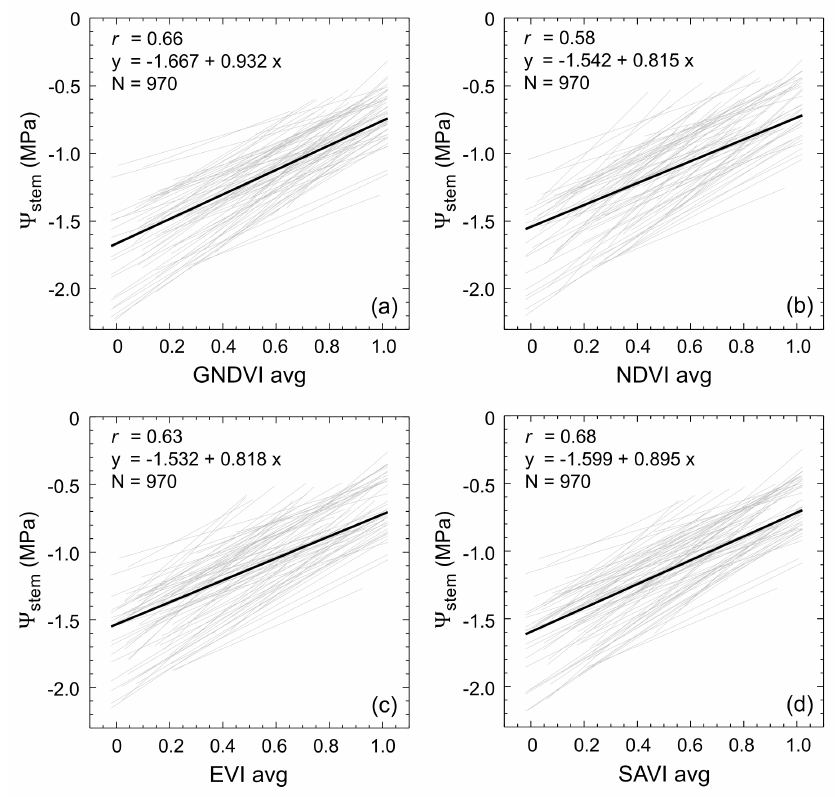
Figure 6. Linear relationships between Planet-derived VI avg: ( a ) GNDVI, ( b ) NDVI, ( c ) EVI and ( d ) SAVI, and Ψ stem in 82 vineyards (grey lines). The general linear fit using all data is also shown (black bold line).